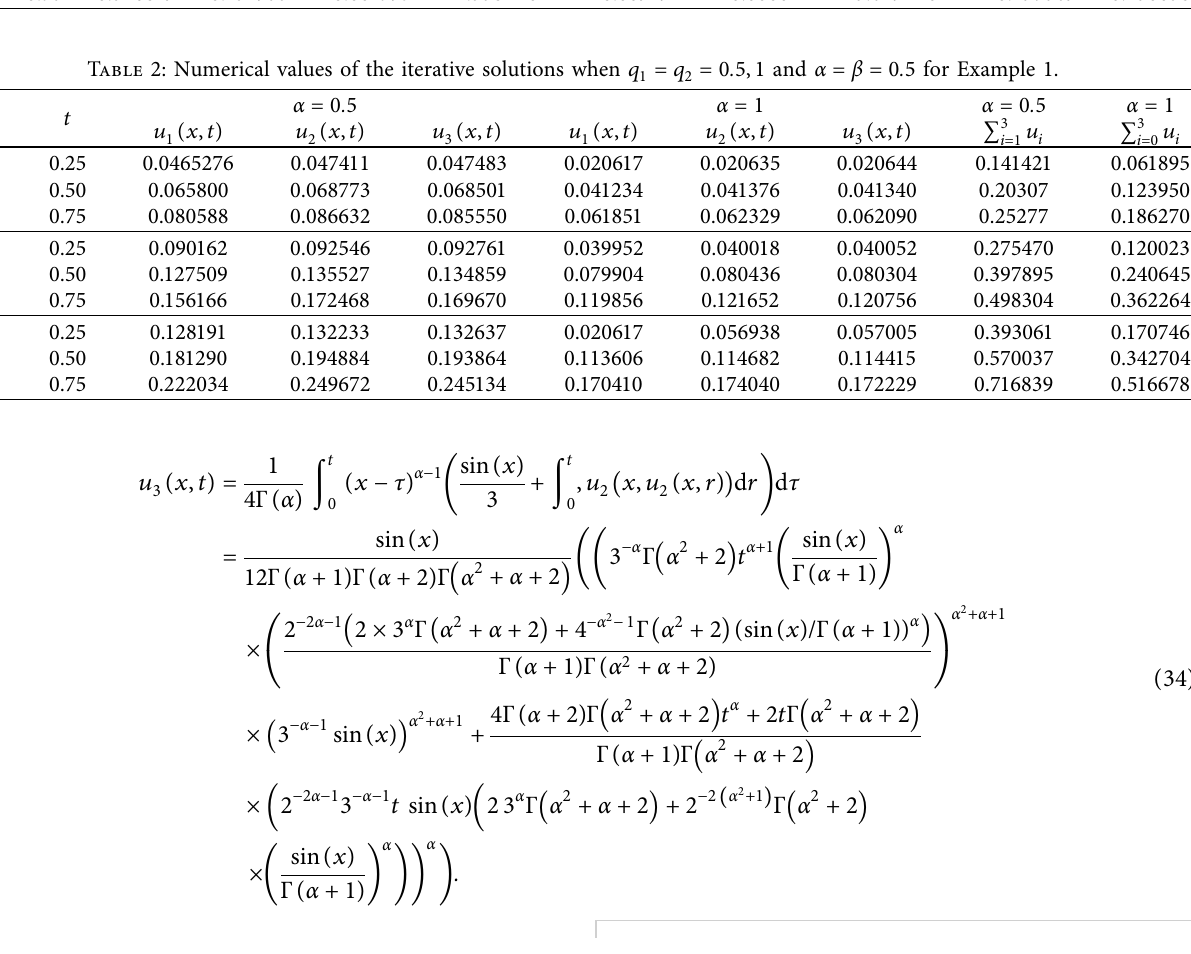
Table 2: Numerical values of the iterative solutions when q